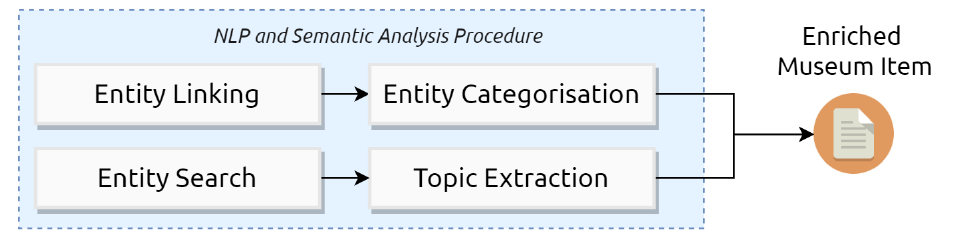
Figure 2. Tasks involved in the NLP and Semantic Analysis